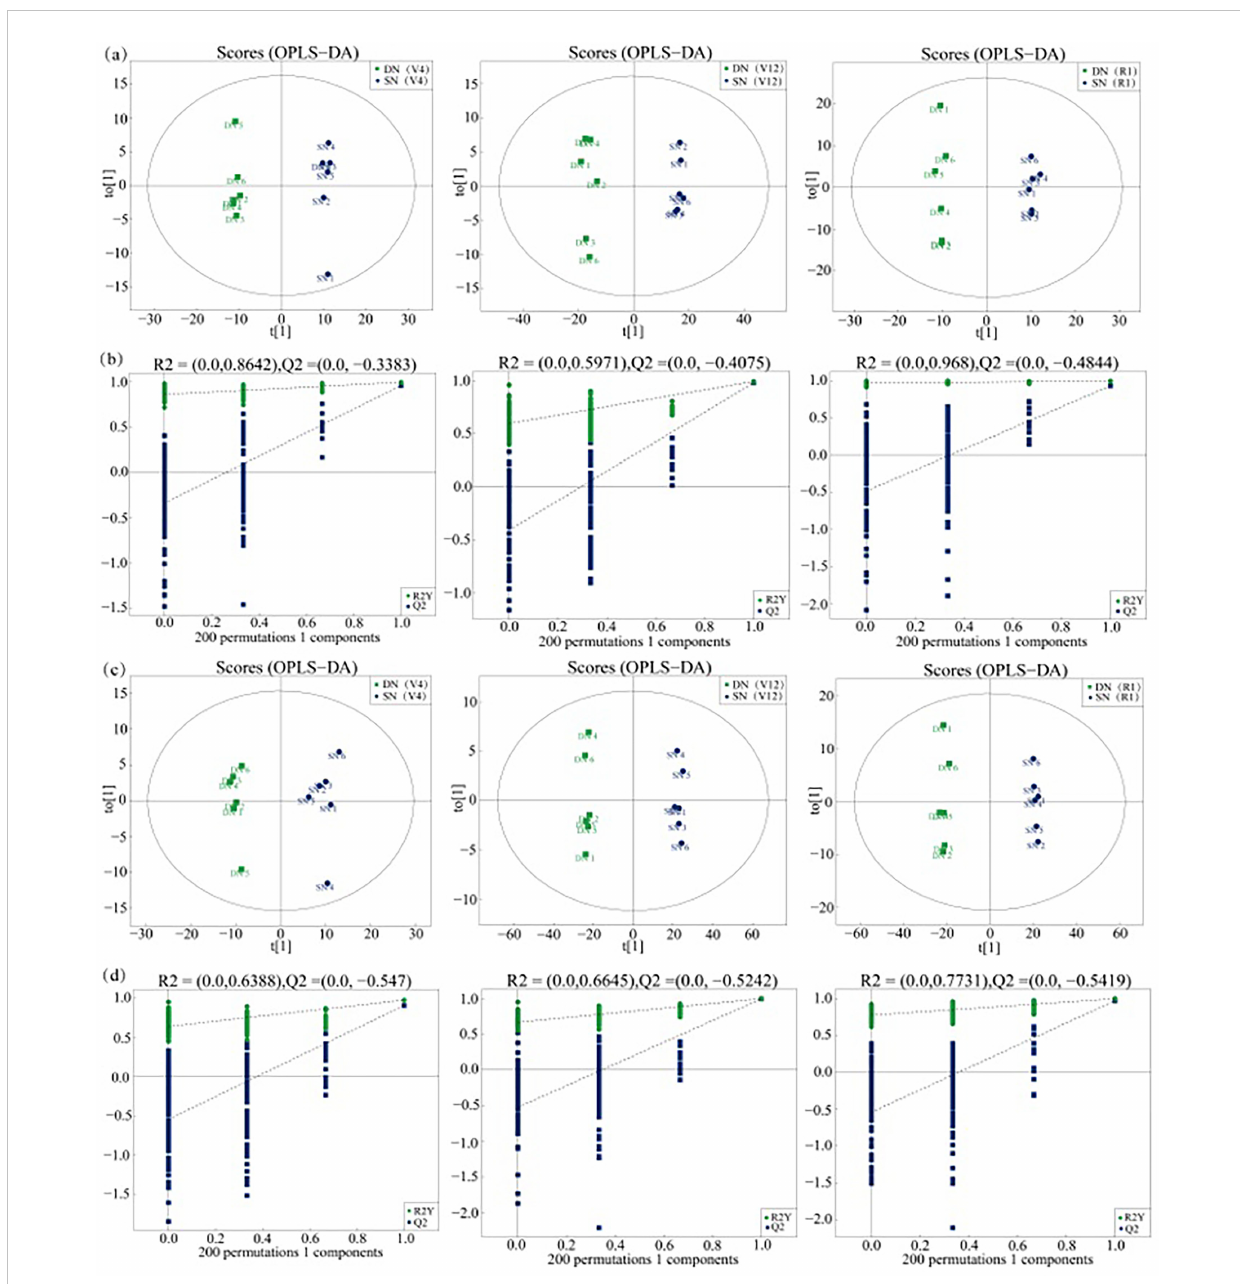
FIGURE 3 OPLS-DA of metabolites extracted from maize leaves under de fi cient nitrogen treatment (DN) and suf fi cient nitrogen treatment (SN). (Note: (A, B) show the score plot and the model evaluation plot of DN-SN analysis in ESI + mode, (C, D) show the score plot and the model evaluation plot of DN-SN analysis in ESI -